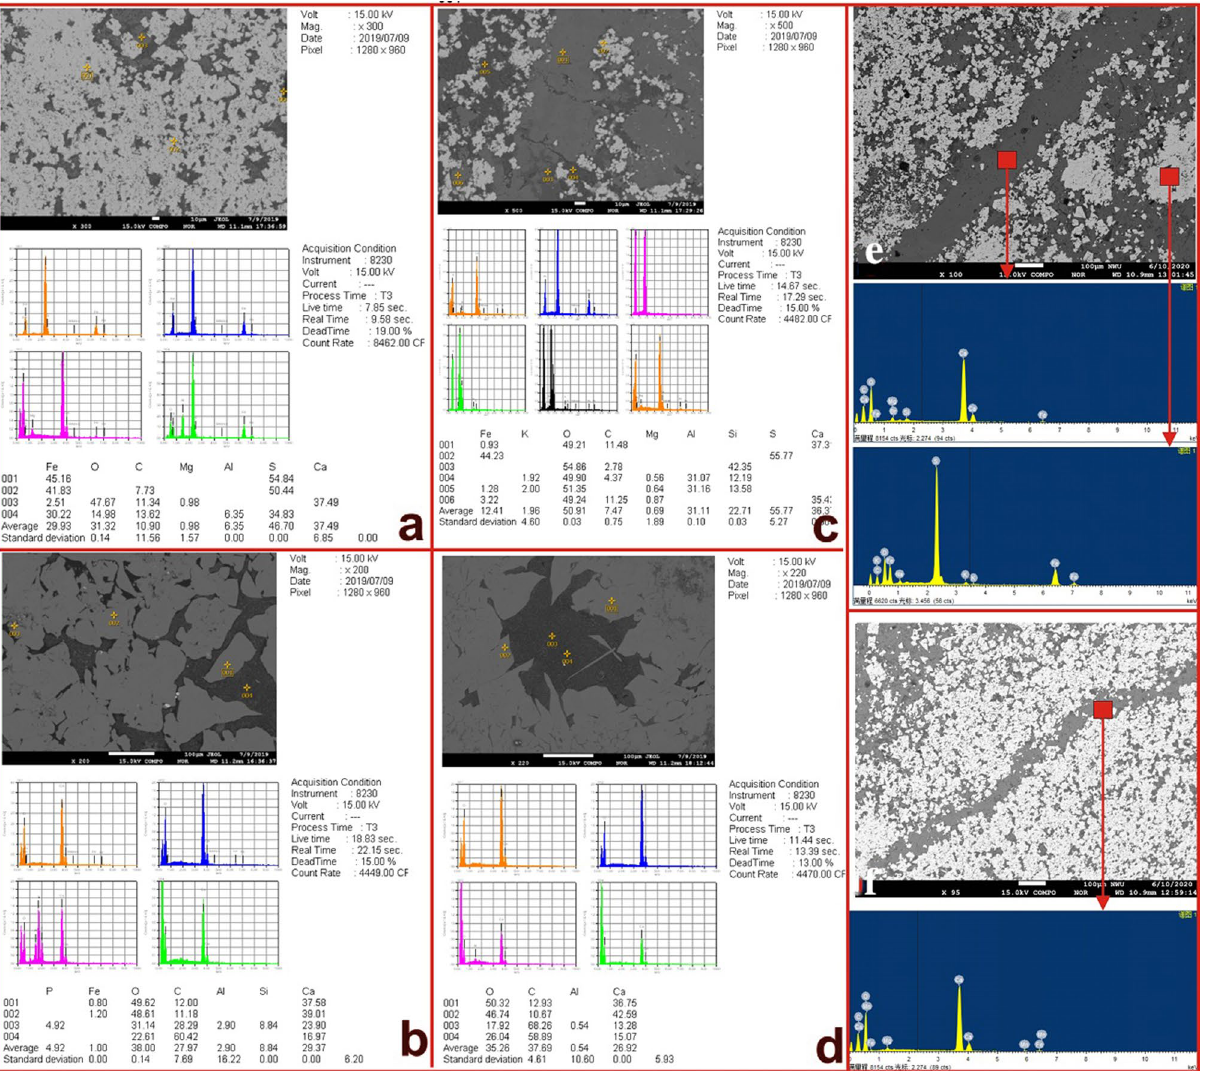
Figure 4. Images of SEM and EDS data for minerals in the study area. ( a ) EDS data for Fig. 2i, white matter is pyrite. ( b ) EDS data for Fig. 2l, calcite. ( c ) EDS data for Fig. 2g, pyrite + iron dolomite + quartz. ( d ) EDS data for Fig. 2l, calcite. Panels ( e , f ) show that the hydrothermal channel is composed of dolomite and